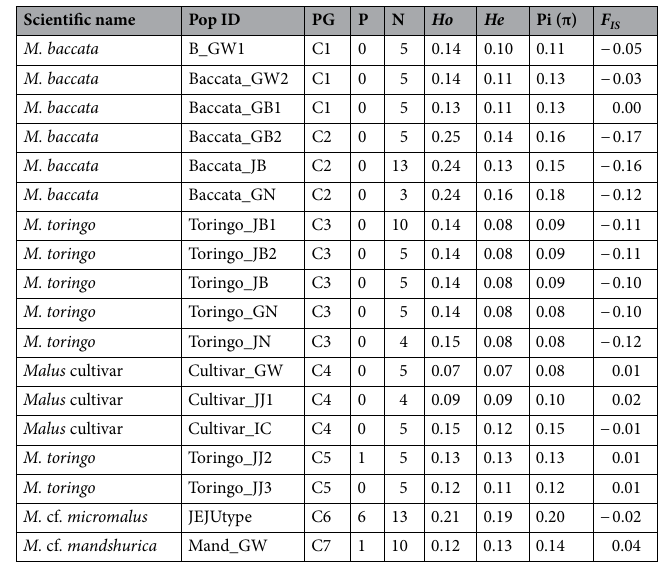
Table 1. Measures of diversity for 112 Malus accessions from five 18 populations calculated from 8426 SNPs. PG , population group; P , private alleles, N , number of individuals; Ho , observed heterozygosity; He , expected heterozygosity; Pi (π), nucleotide diversity; F IS , inbreeding